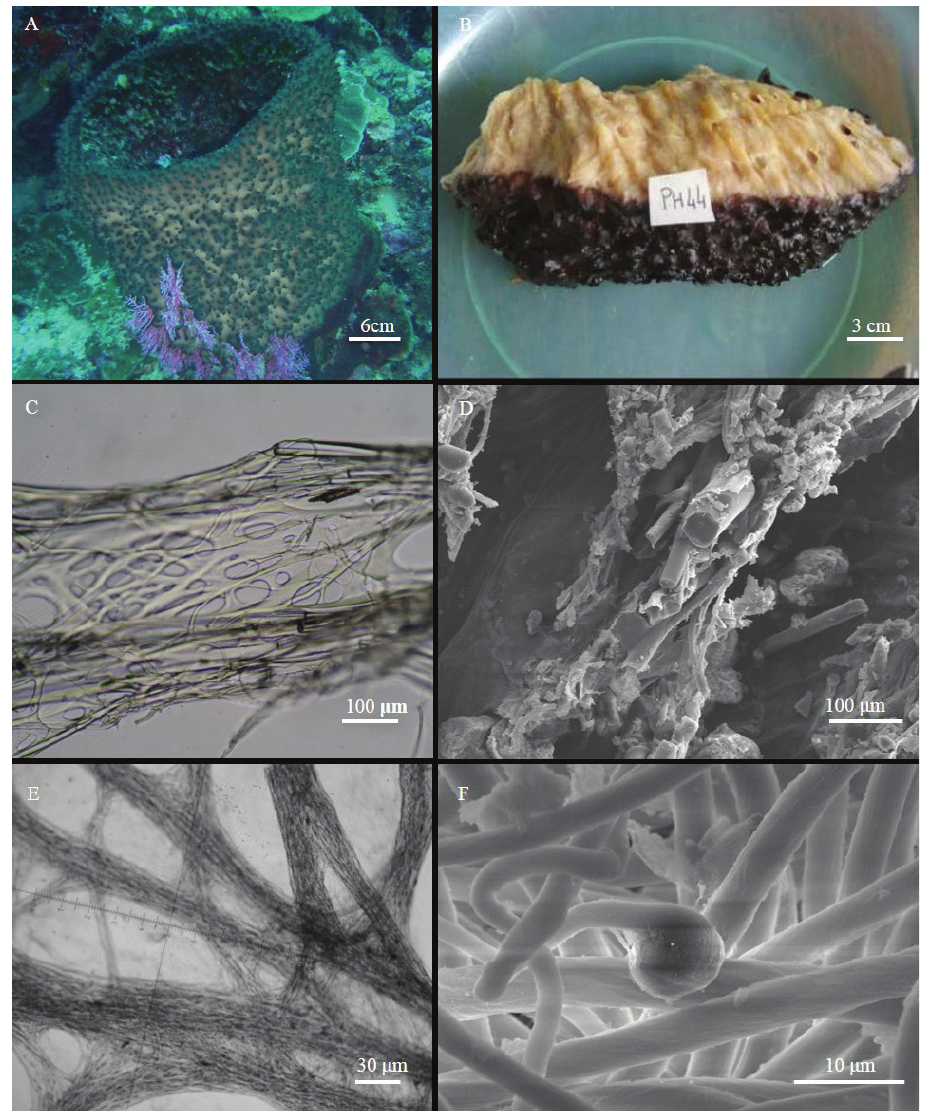
Figure 10. Ircinia colossa sp. n. A specimen BU-590 in situ B portion of the holotype C fasciculated fibres D primary fibres with foreign spicules E filaments organised in tracts F filaments with a terminal knob in